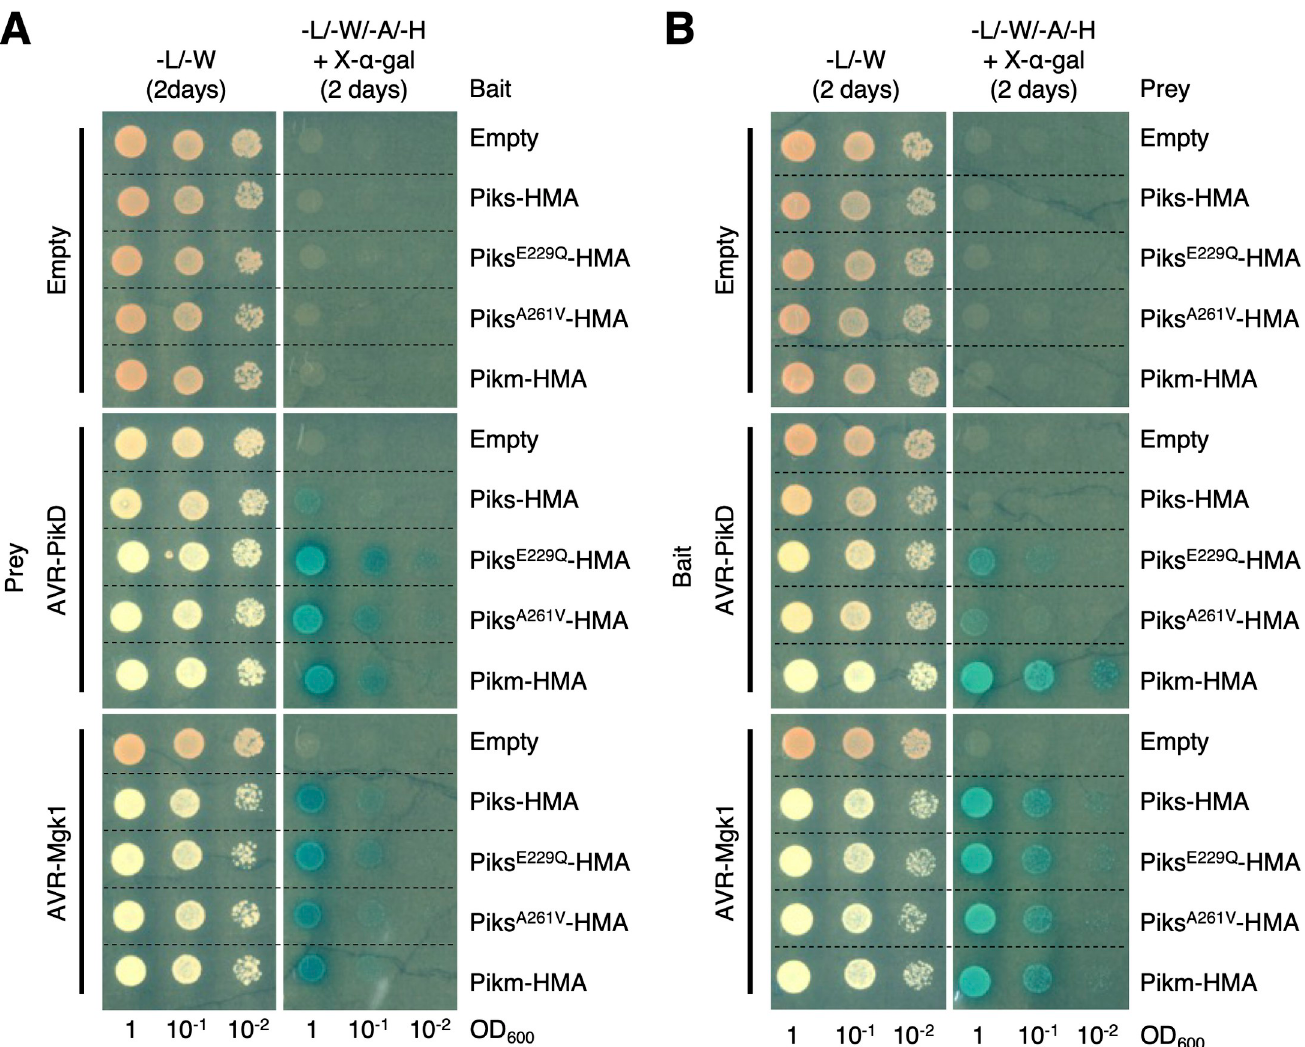
Fig 9. Yeast two-hybrid assay shows that the polymorphisms (E229Q and A261V) between Piks-HMA and Pikm-HMA quantitatively affect their binding to AVR-PikD. (A) HA-tagged AVRs as prey and Myc-tagged HMA domains as bait. (B) Myc-tagged AVRs as bait and HA-tagged HMA domains as prey. Empty vector was used as a negative control. Left side: basal medium lacking leucine (L) and tryptophan (W) for growth control. Right side: basal medium lacking leucine (L), tryptophan (W), adenine (A), and histidine (H) and containing X- α -gal for selection. AVR, avirulence; HMA, heavy